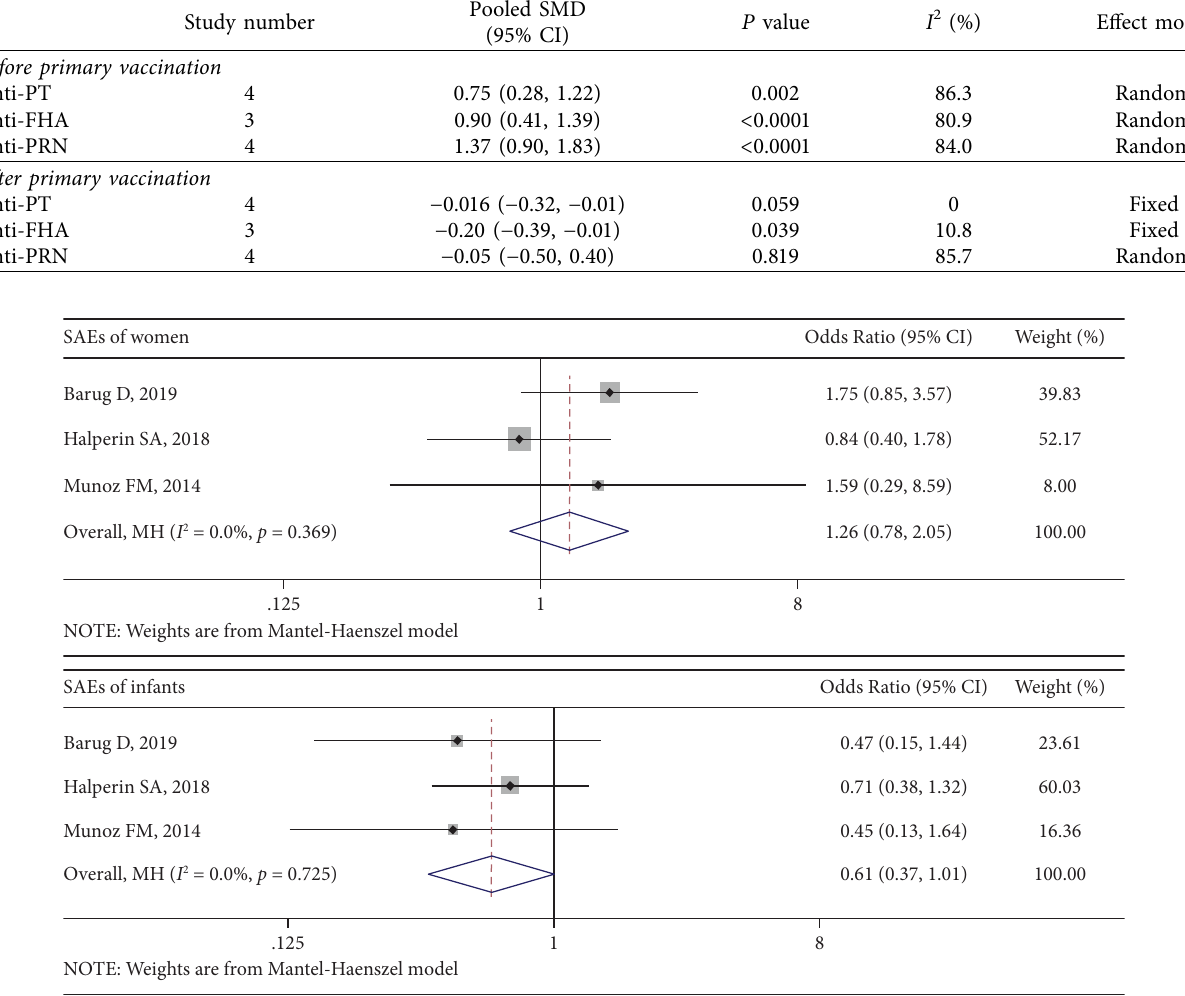
Table 2: Meta-analysis results of GMCs for pertussis antibodies before and after primary vaccination of infants.